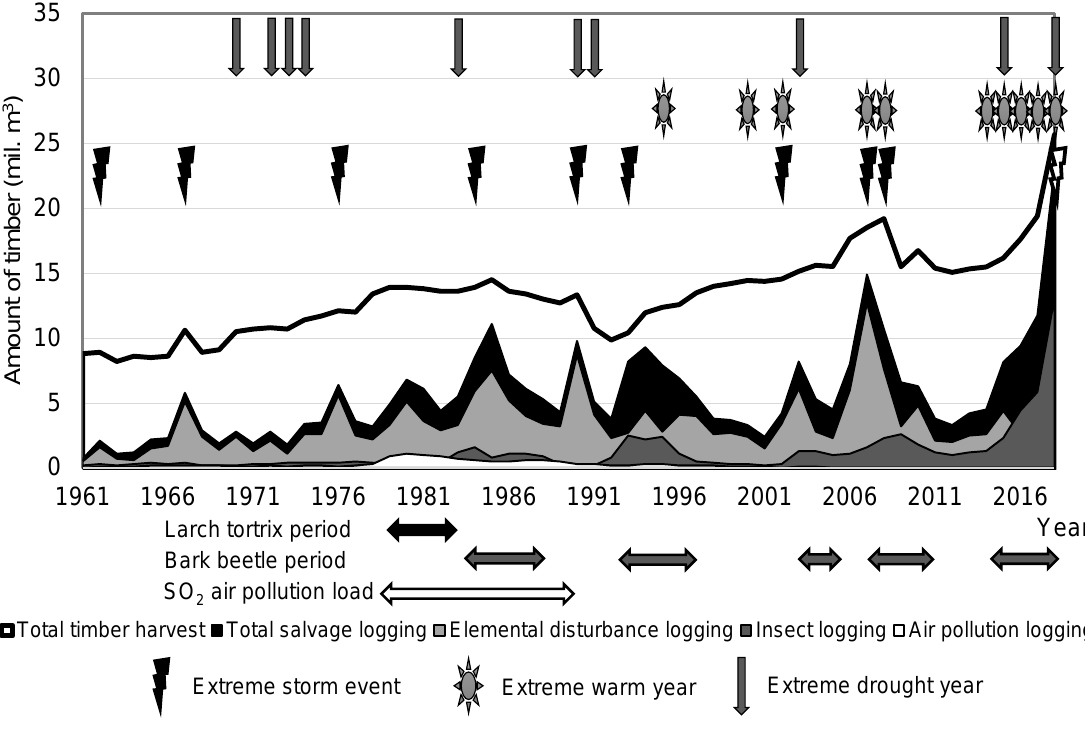
Figure 3. Dynamics of total timber harvest and salvage logging (elemental disturbance logging, insect logging, air pollution logging) in relation to extreme events in the Czech Republic.